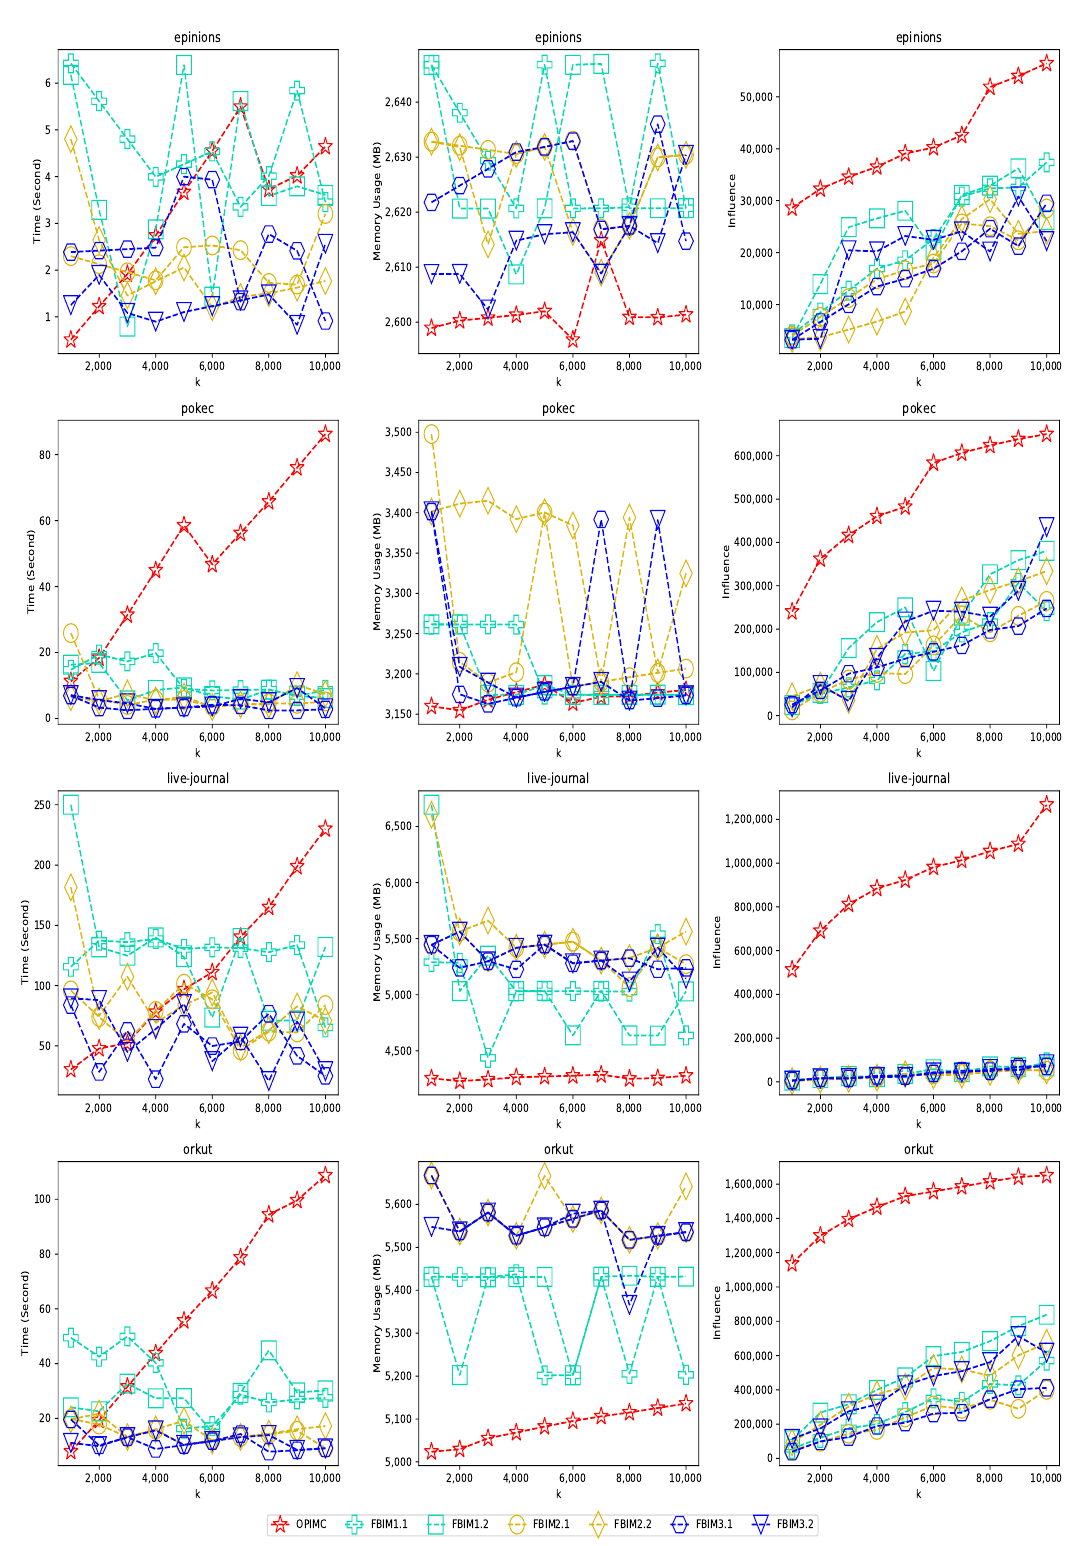
Figure 1. Running time, memory usage, and influence for Experiment 1 under the LT